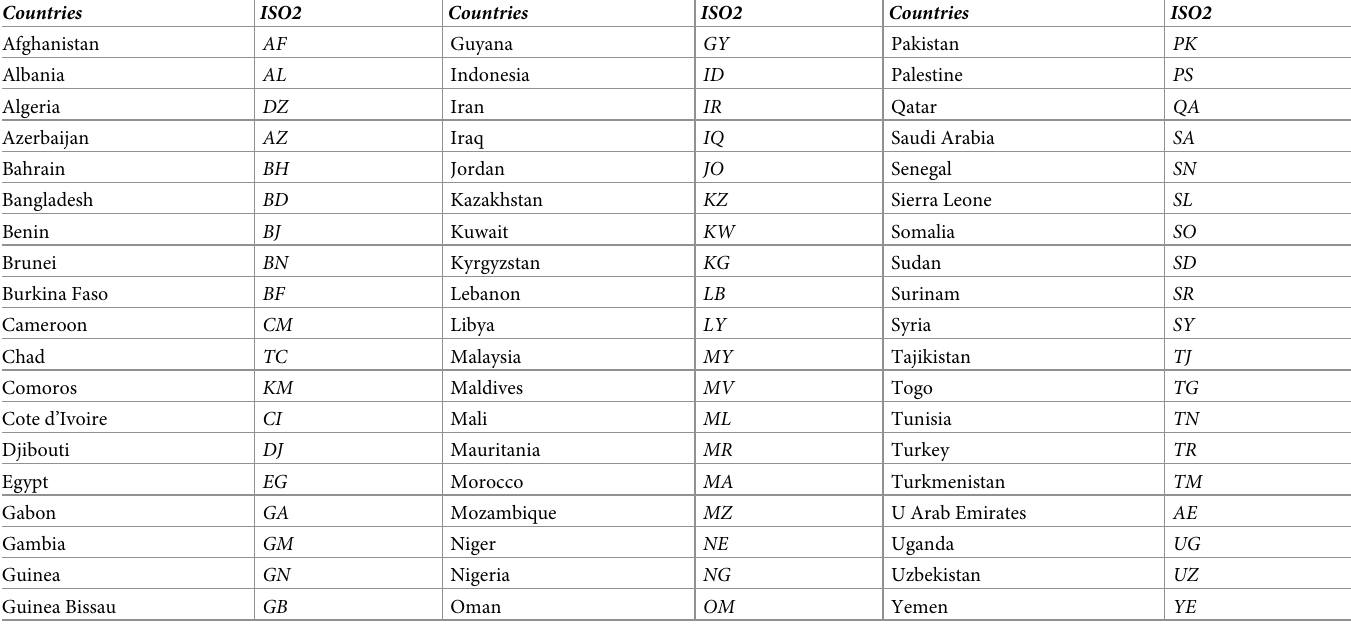
Table 1. List of the 57 countries in the Organisation of Islamic Co-operation group, with their ISO2 codes. Countries ISO2 Countries